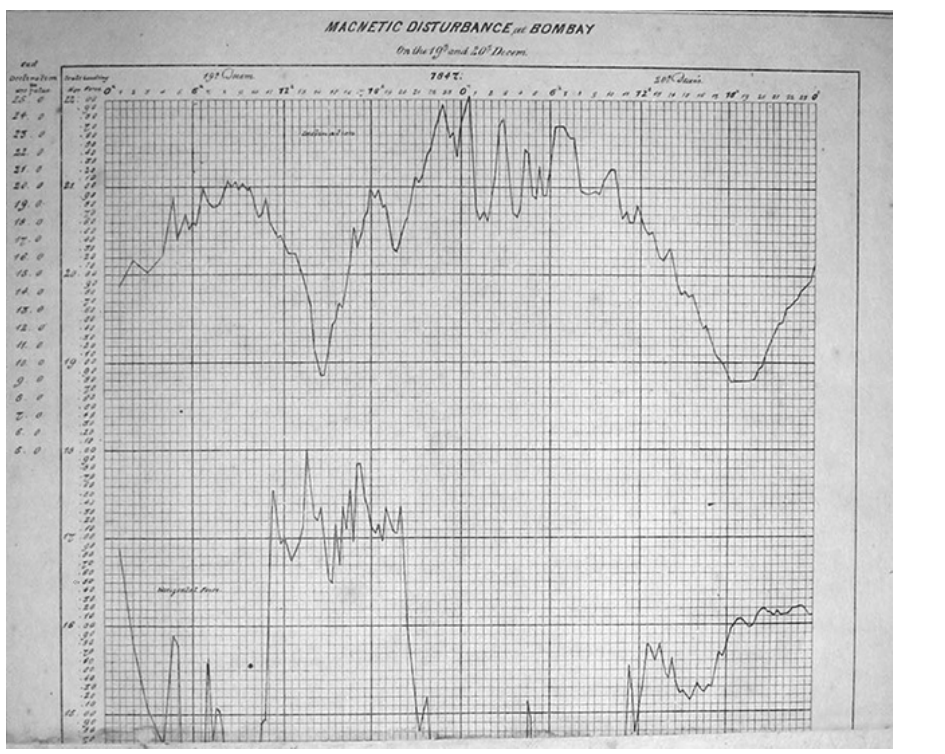
Figure 17. Magnetic disturbance recorded at Colaba on 19–20 December 1847 (Orlebar,